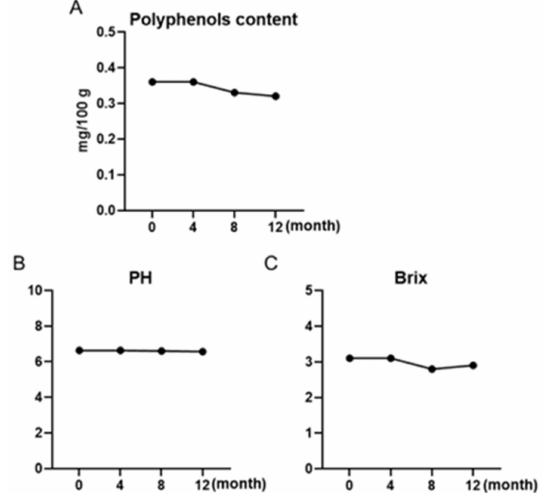
Figure 1. Changes in maple water total phenolic content ( A ), ◦ Bx ( B ), and pH ( C ) during a storage time of 12 months at room temperature. Each sample was measured at time points of 0, 4, 8, and 12